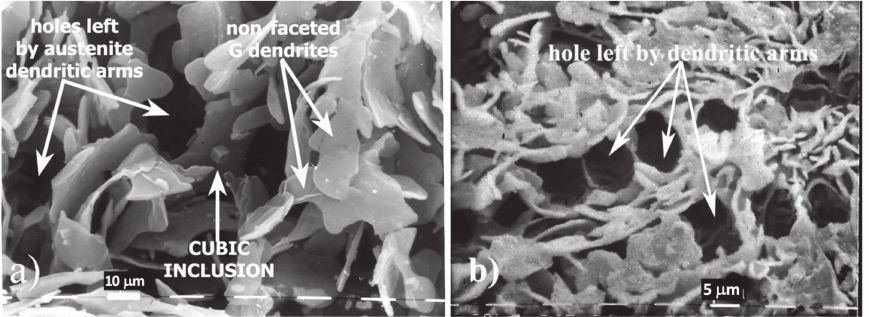
Figure 11. SEM images from non-faceted G of graphite lamellas of gray cast iron, ( a ) type D and ( b ) type